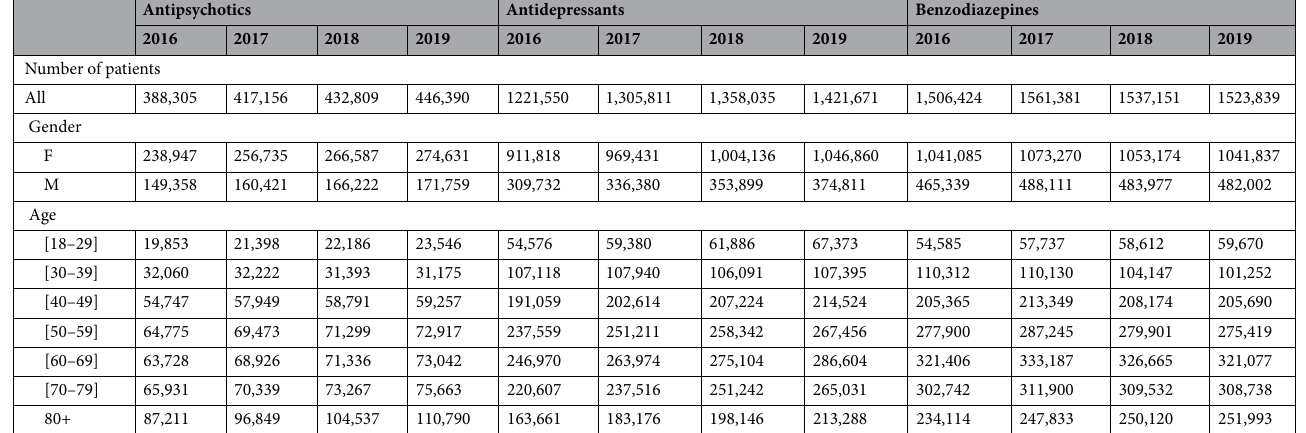
Table 3. Number of patients with an active prescription of psychotropic drugs per demographic group.